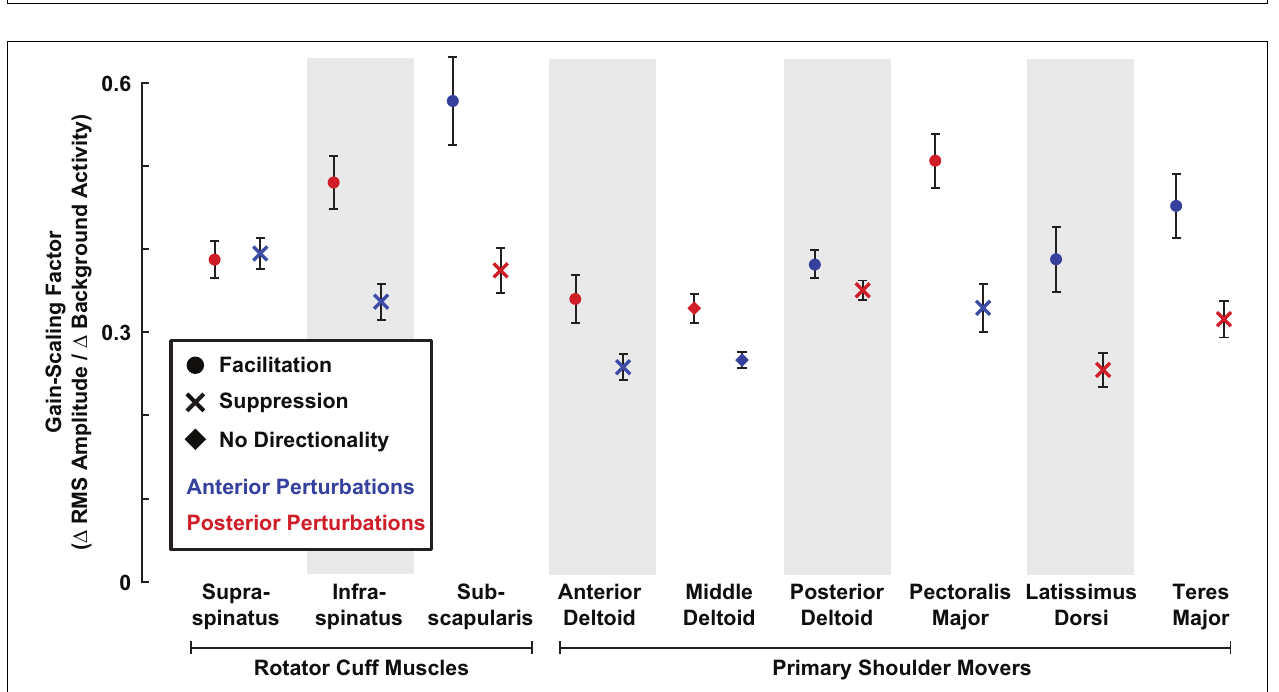
FIGURE 6 | Gain-scaling in all shoulder muscles. The gain-scaling factor for each muscle was estimated from the relationship between the RMS amplitude and background activity in each muscle stratified by perturbation direction. Error bars represent the standard errors of the estimated gain-scaling factors.